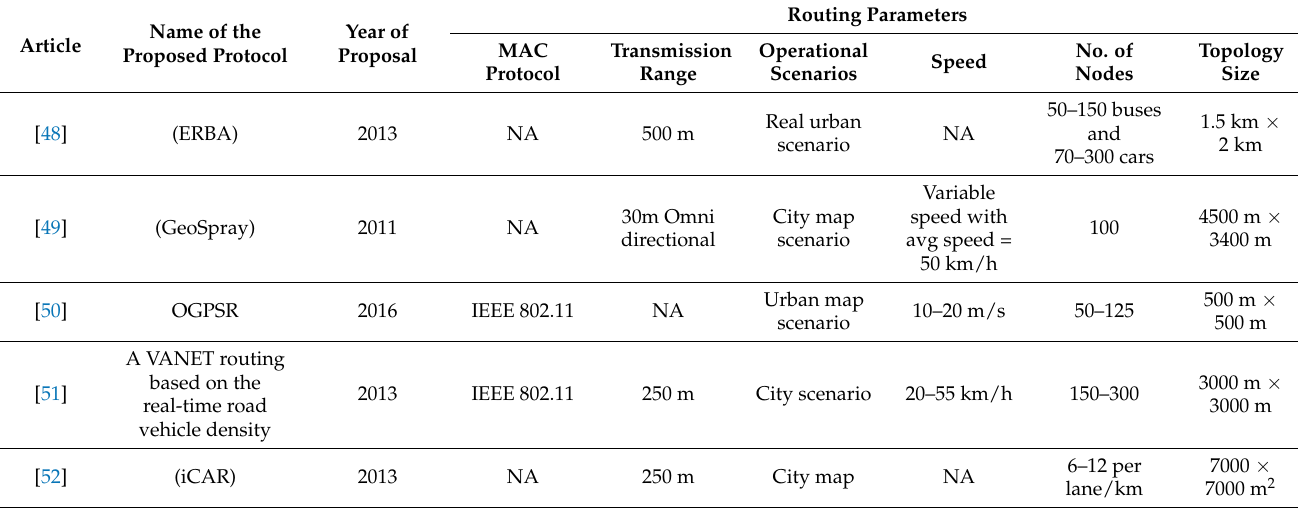
Table 11. Routing parameters of city map scenario-based routing protocols.